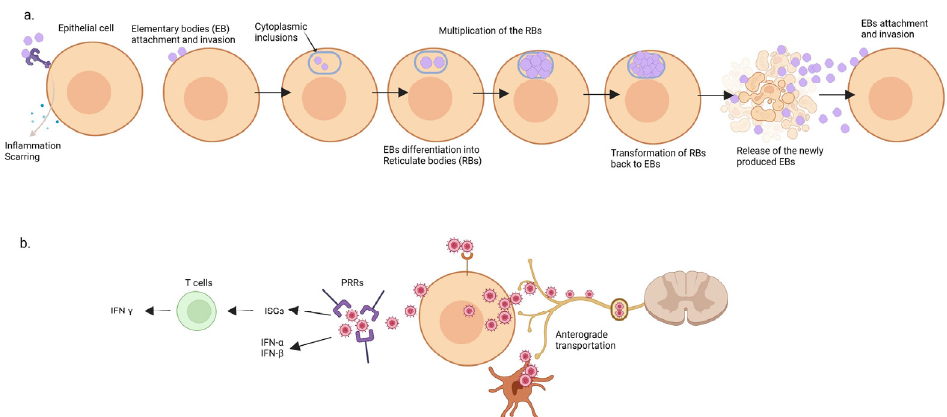
Figure 2. Host interaction in Chlamydia and herpes simplex. ( a ) Chlamydia life cycles alternate between the elementary bodies and the reticulate bodies. Chlamydiosis inflammation may resolve with local scarring. ( b ) Herpes simplex virus binds pattern recognition receptors (PRRs) and stimulates IFN ( α , β , γ ) production. Following proliferation within the epidermal keratinocytes and Langerhans cells, the herpes virus undergoes anterograde transportation and enters the dormant stage inside the dorsal root ganglia. ISG = interferon-stimulated genes; PRR = pattern recognition receptor.